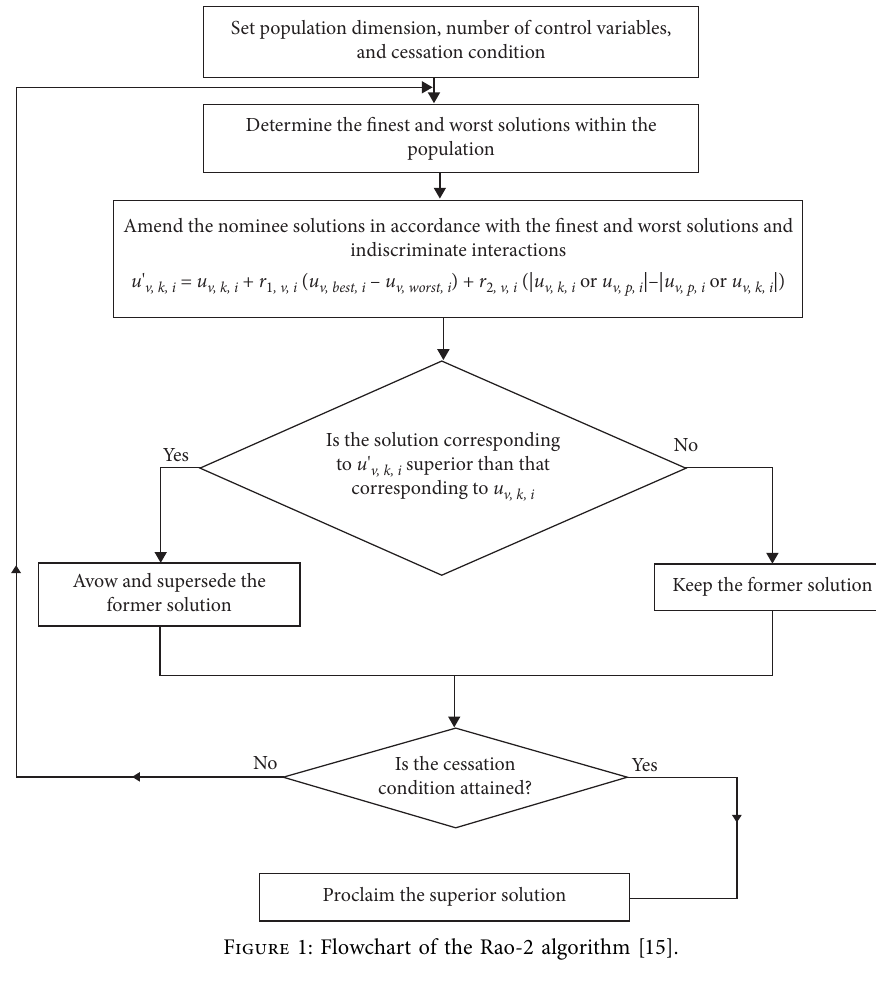
Figure 1: Flowchart of the Rao-2 algorithm